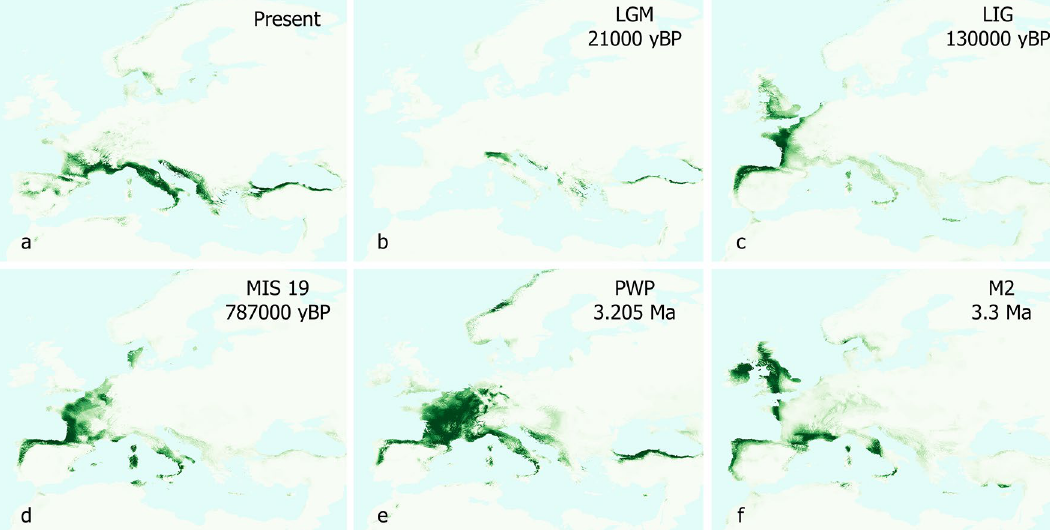
Figure 2. ENM of Salamandrina at the European scale: model for present day ( a ) and projections of the model on different time bins, from Pleistocene ( b – d ) to Pliocene ( e , f ). Climatic suitability is reported on a scale between 0 (white) and 1 (darkest green). It is worth noting that Italy is the Mediterranean peninsula showing the most temporally extended areas of suitable climate (dark green) for Salamandrina , whereas suitable